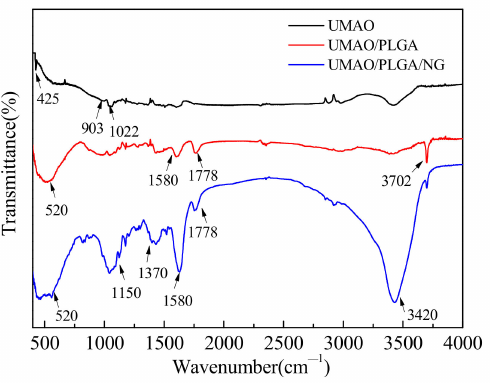
Figure 2. Fourier transform infrared spectrograph (FT-IR) spectra of different coatings.